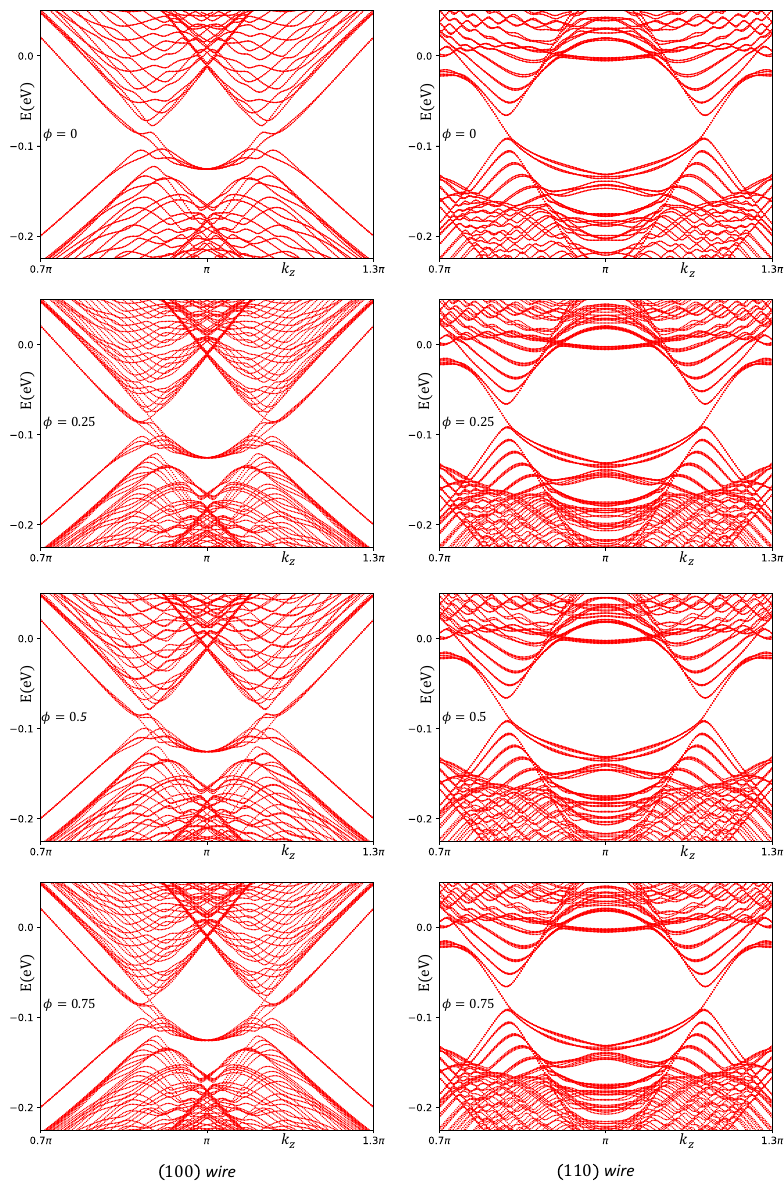
Figure 7: Spectra of the ( 100 ) wire (left column) and the ( 110 ) wire (right column), = π also for non-zero flux values: φ = 0,0.25,0.5,075, remain symmetric around k z for first, second, third and fourth rows,